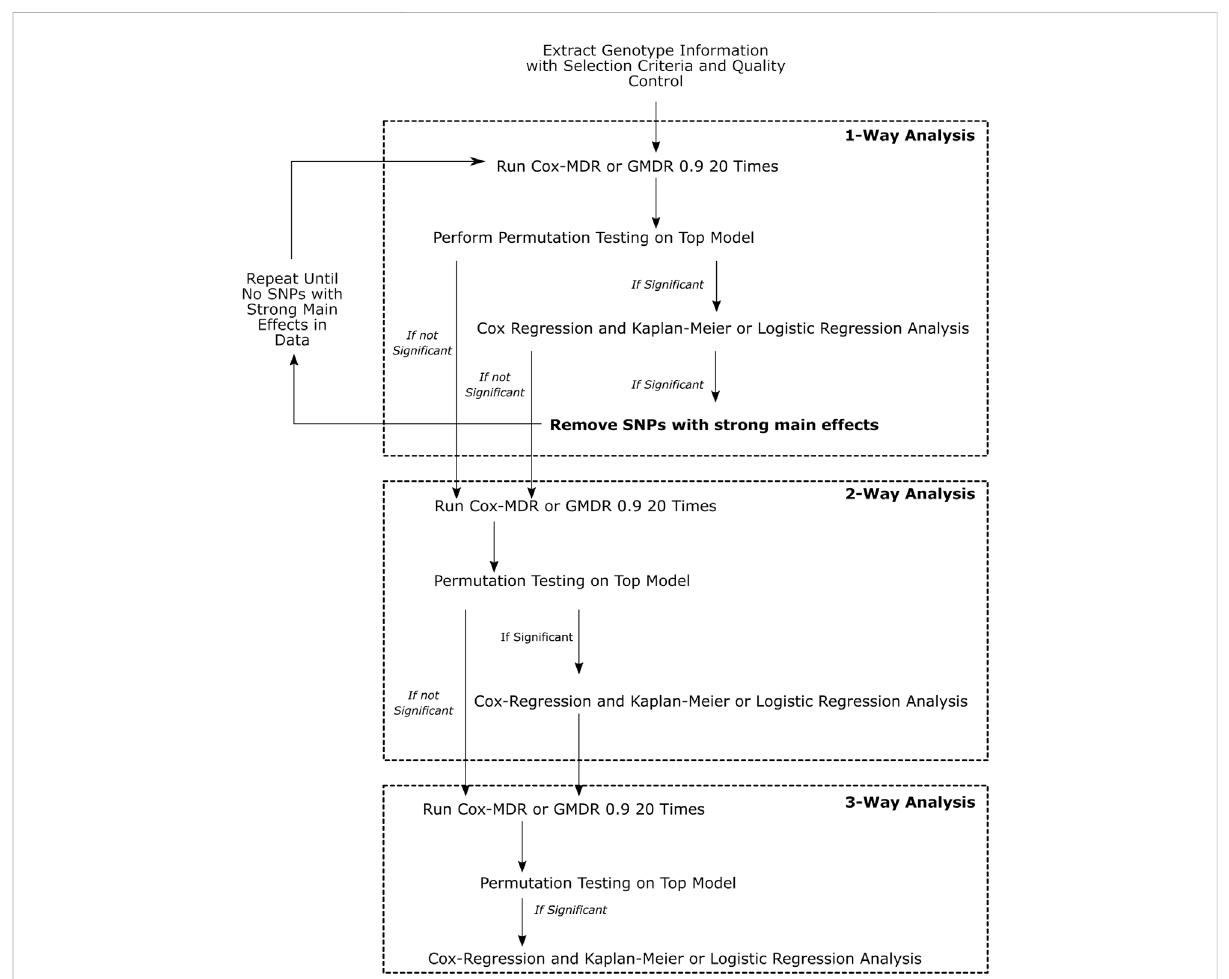
FIGURE 1 This fi gure demonstrates the overall work fl ow of the analyses performed. Multivariate Cox-regression and univariate Kaplan-Meier analyses were used to verify the Cox-MDR results and assess the associations of the identi fi ed genotype groups with clinical outcomes, whereas multivariate logistic regression was used to verify the GMDR 0.9 results and the association of the identi fi ed genotype groups with clinical